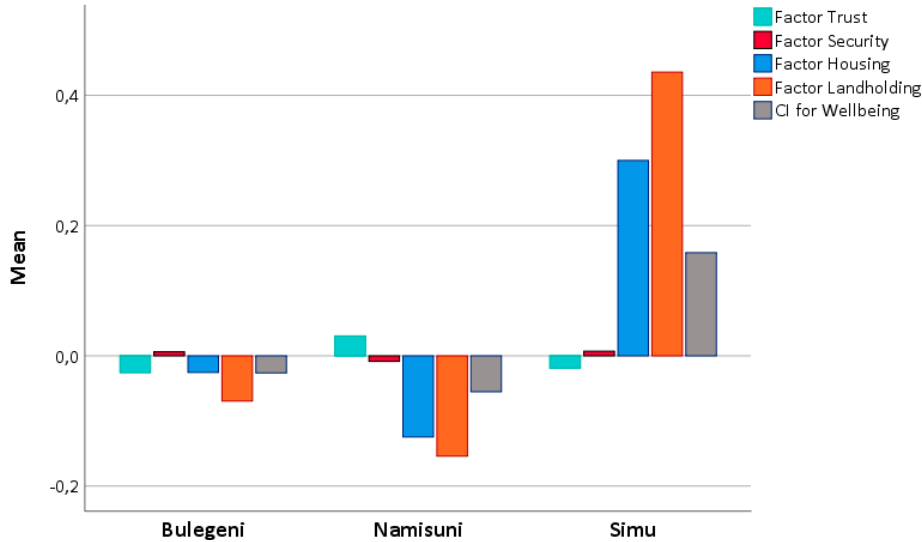
Figure 4. Means for the factors trust, security, housing, and landholding, and the CI of wellbeing for the sub-counties Bulegeni, Namisuni, and Simu (after z-score